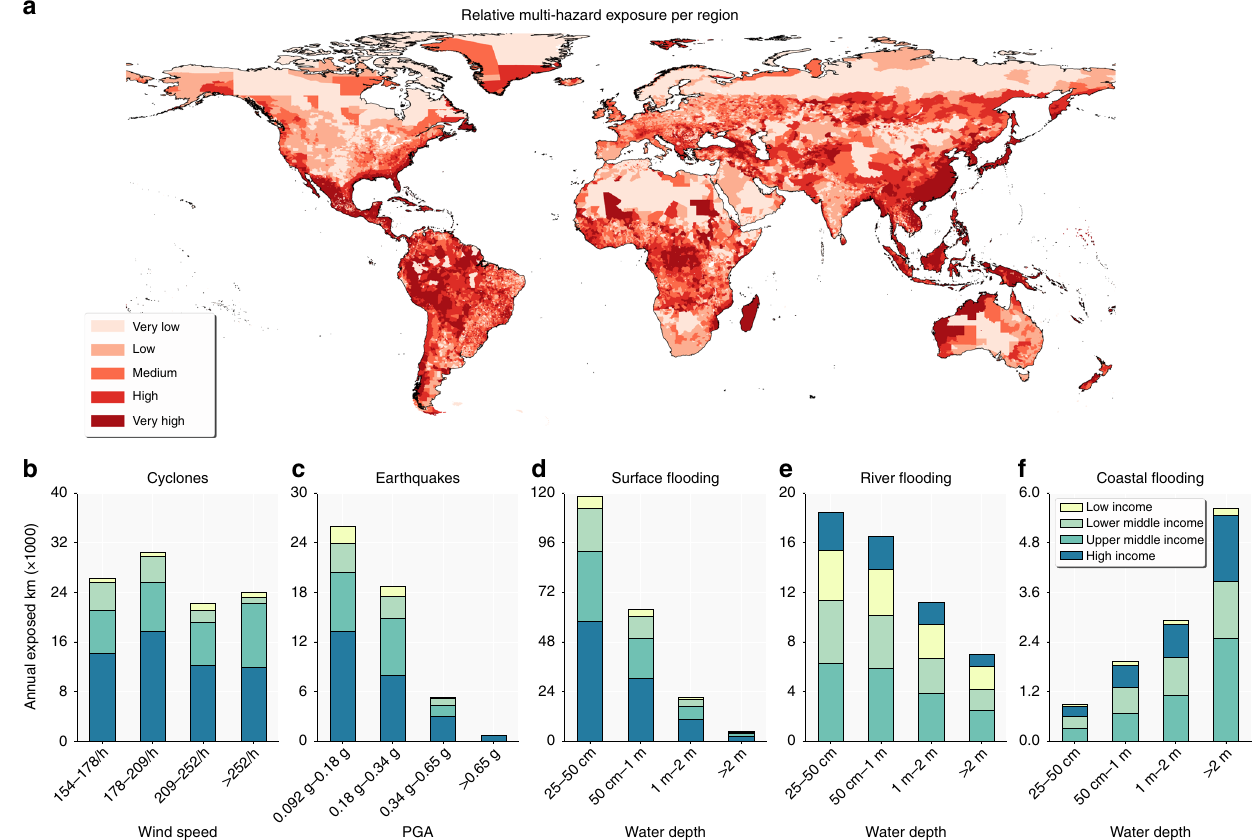
Fig. 1 Global multi-hazard transport infrastructure exposure. Panel a presents the exposure for each region in the world. The classi fi cation is based on 20th percentiles. Panels b – f presents the exposure for the four income groups per hazard and per hazard intensity band. See Methods for further discussions on the justi fi cation on these hazard